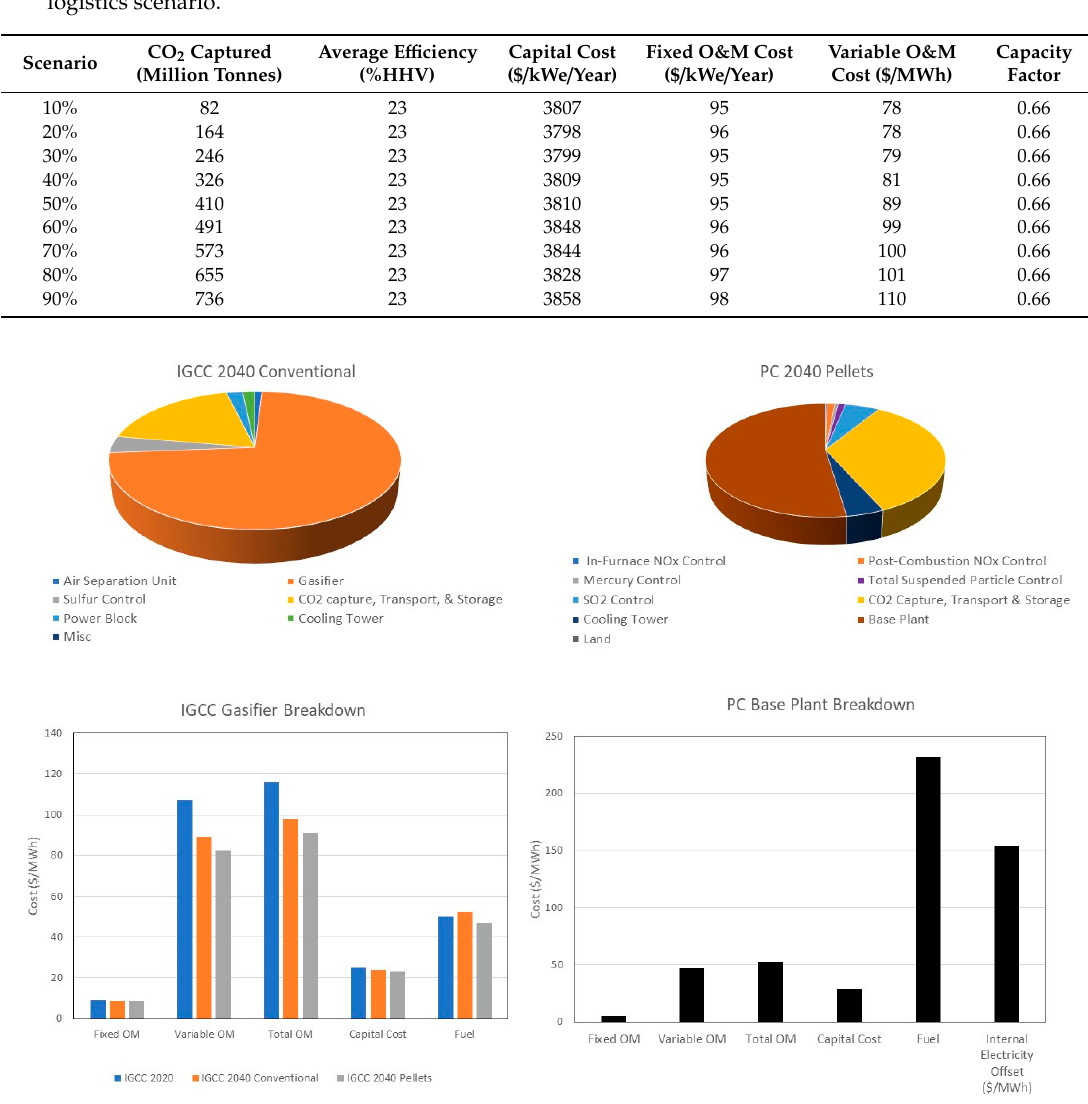
Figure 7. Example breakdowns from the 50% CO 2 capture scenario of the average levelized cost of electricity (LCOE) across cost components of the IGCC and pulverized combustion plants are shown in the top pie graphs. Cost components of the IGCC gasifier and pulverized combustion base plant are shown in the corresponding bar graphs.